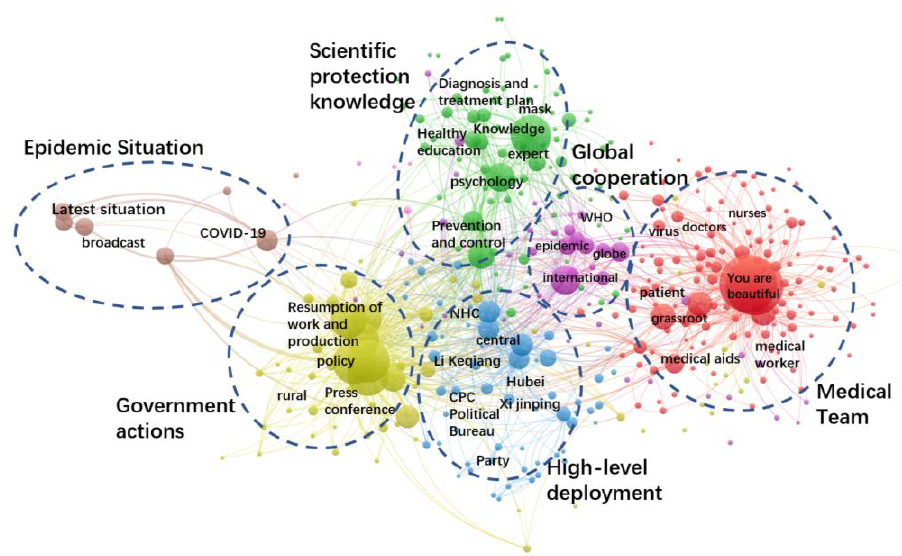
Figure 2. Keywords co-occurrence network of government information supply.